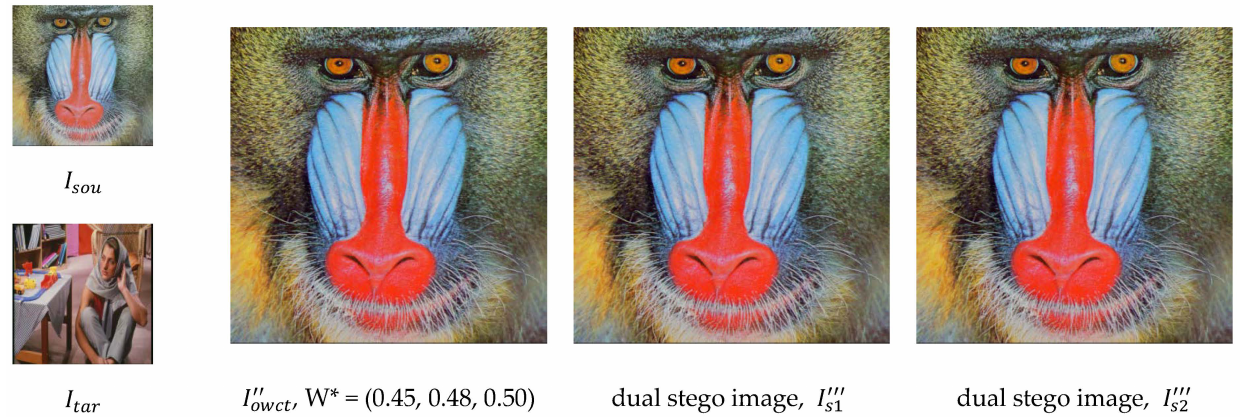
Figure 5. The visual inspection of the test image “Baboon”.